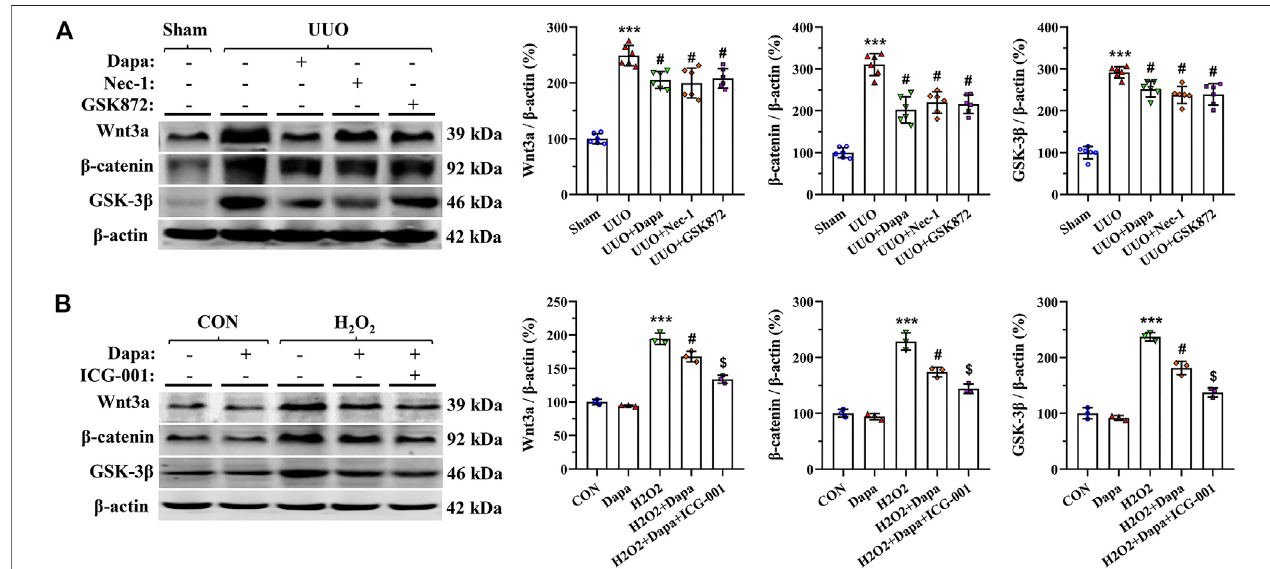
FIGURE 7 | Representative photomicrographs of immunoblotting analysis of Wnt3 α / β -catenin/GSK-3 β signaling proteins in vivo (A) and in vitro (B) . Data are presented as mean ± SEM ( in vivo , n (cid:2) 6; in vitro , n (cid:2) 3) and analyzed by one-way ANOVA. *** p < 0.01 vs sham or control; # p < 0.05 vs. UUO or H 2 O 2 ; $ p < 0.05 vs H 2 O 2